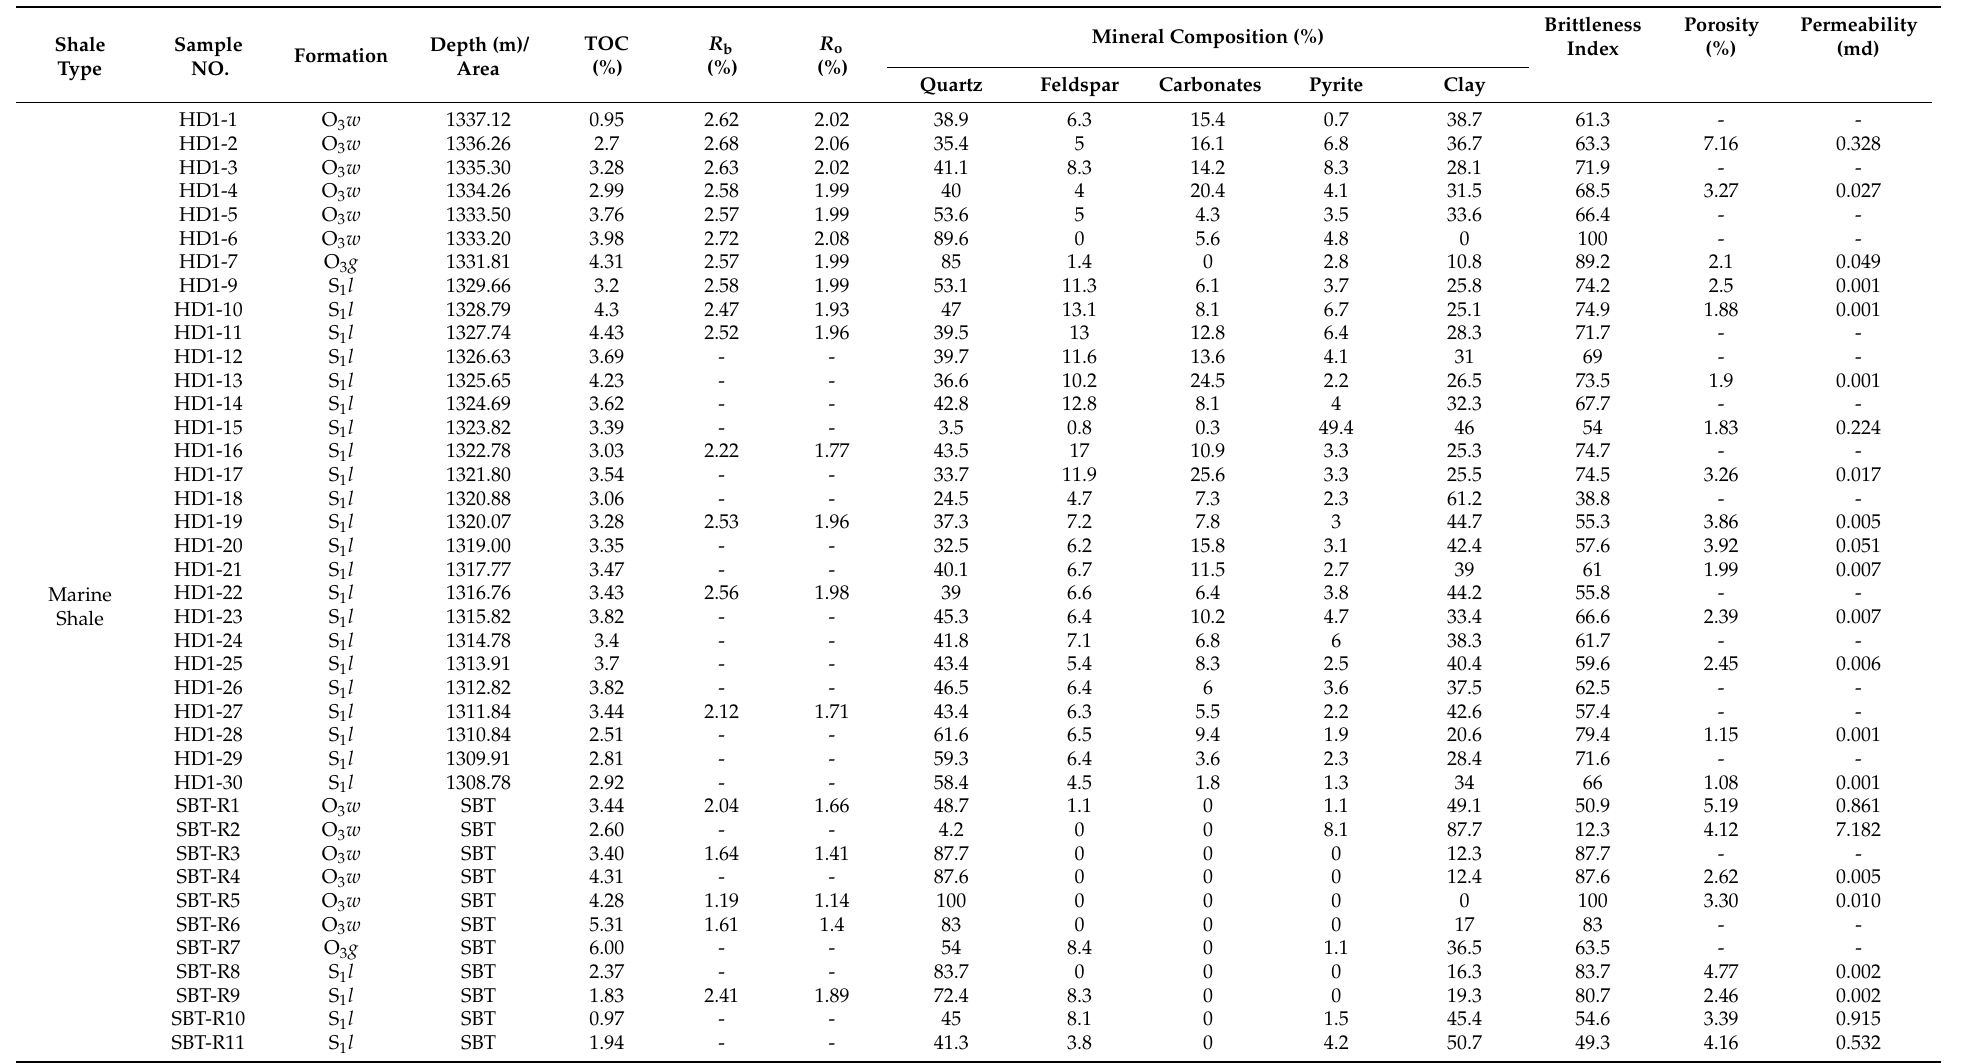
Table 1. The organic geochemistry, mineralogical composition and reservoir physical properties of the marine and lacustrine shale in the study area. Shale Sample Type